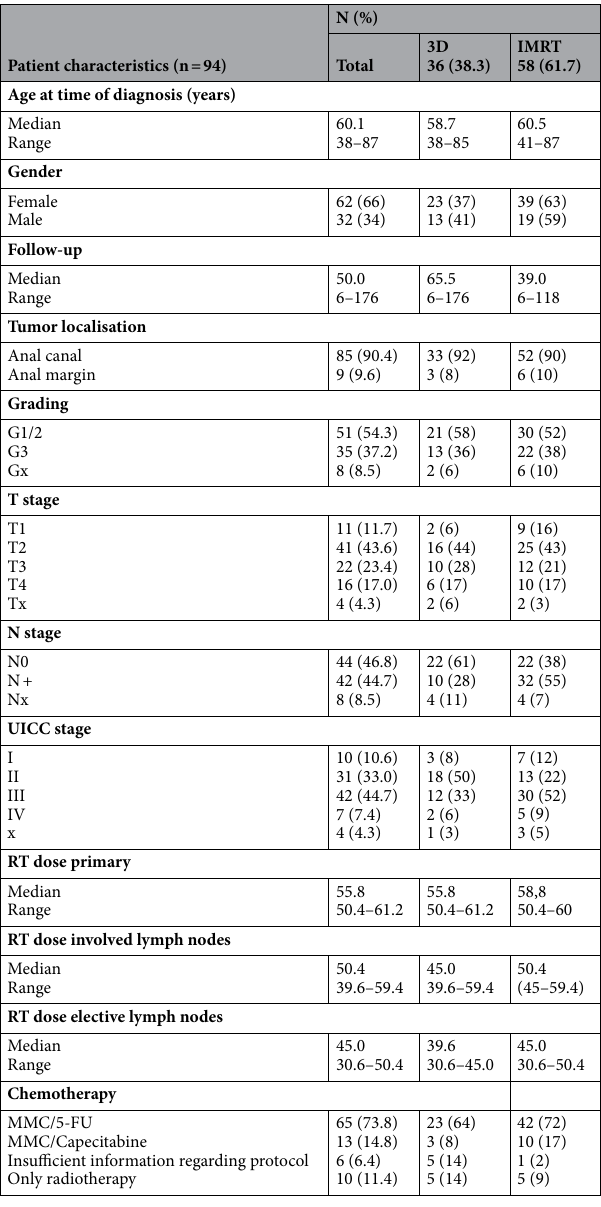
Table 1. Patient